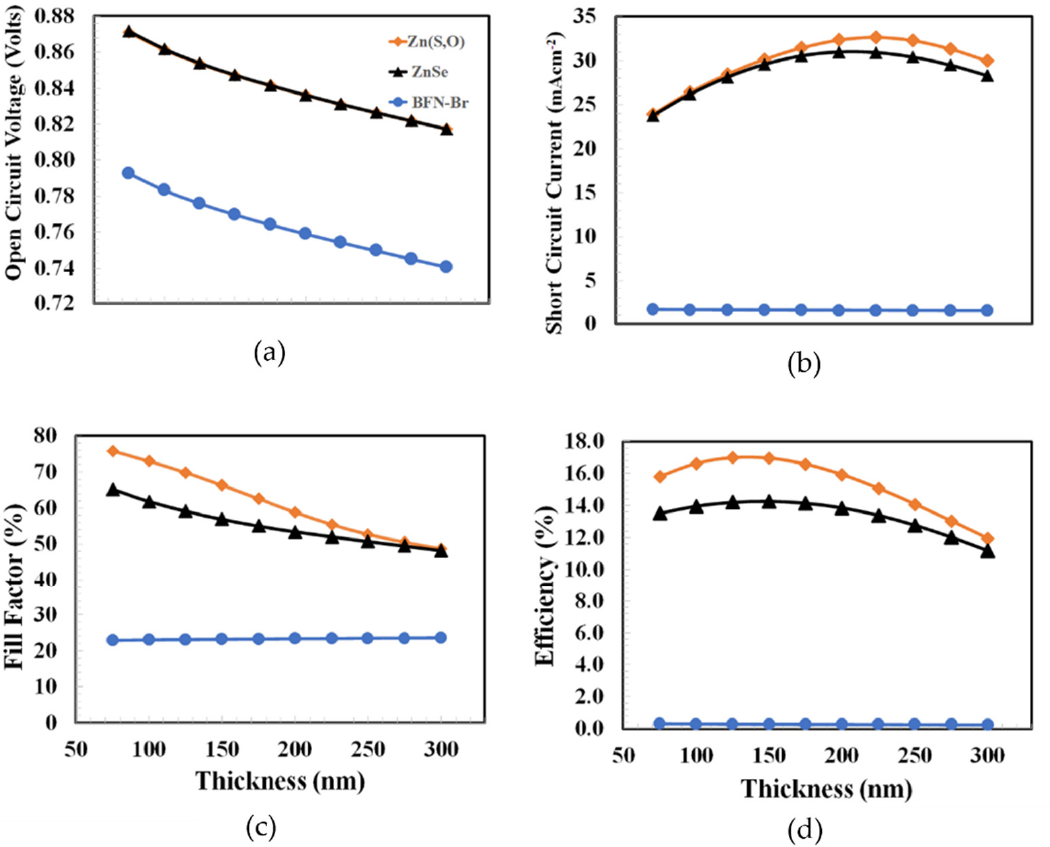
Figure 7. The photovoltaic parameters of ( a ) open-circuit voltage, ( b ) short-circuit current, ( c ) fill factor, and ( d ) power conversion efficiency as a function of the PTB7:PCBM active layer thickness for ITO/Zn(O,S)/PTB7:PCBM/PEDOT:PSS/Au, ITO/ZnSe/PTB7:PCBM/PEDOT:PSS/Au, ITO/PFN- Br/PTB7:PCBM/PEDOT:PSS/Au, respectively.